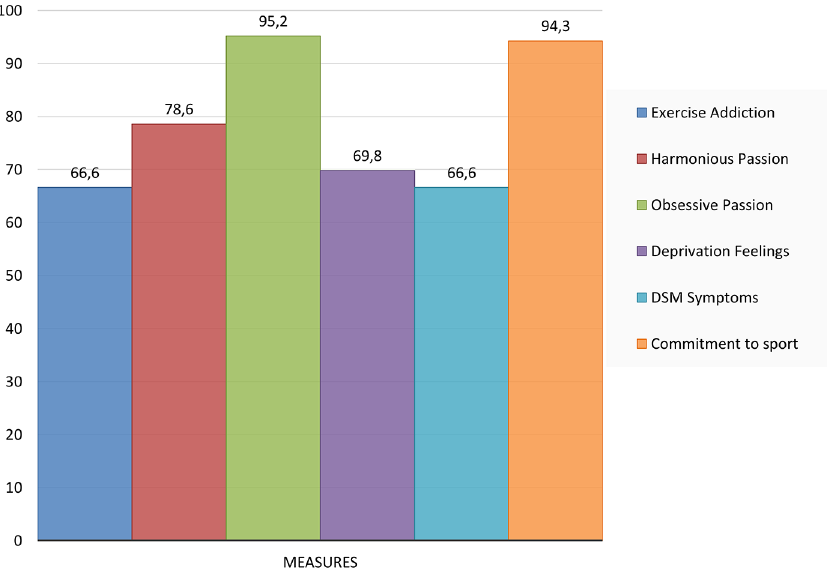
Figure 1. Evelyn's scores in percent (%) of the maximum (vertical axis range 0-100) on six measures of exercise behaviour. Qualitative Measures